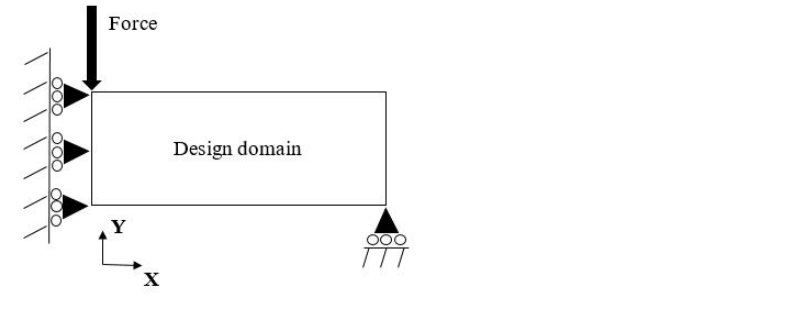
Figure 6. Schematic of design domain and loading condition for the half-MBB